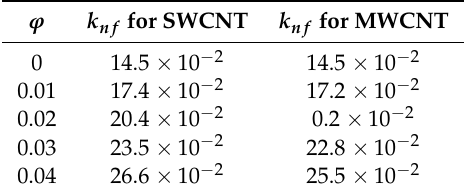
Table 11. Influence of the volume fraction ϕ on thermal conductivity k nf